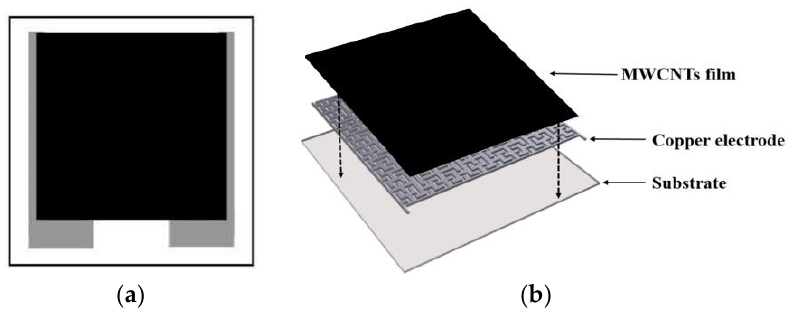
Figure 5. Illustration of sensor structure. ( a ) Top view; ( b ) side view.